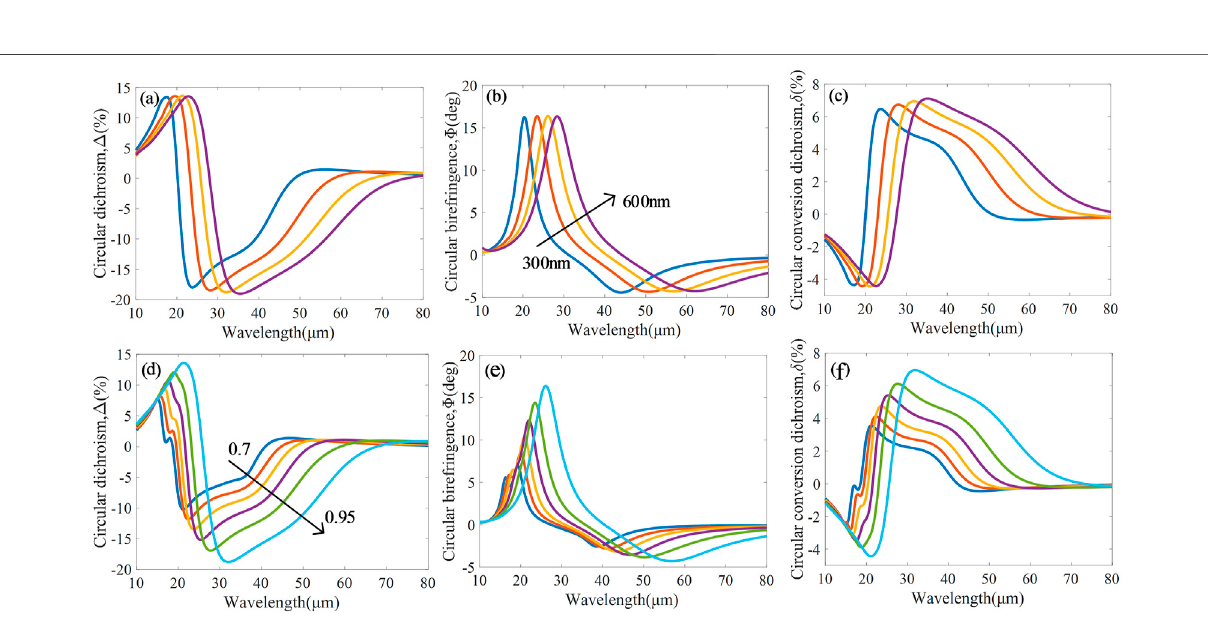
FIGURE 2 | Dependences of (A) circular dichroism, (B) circular birefringence, and (C) circular conversion dichroism on the period of the square BP metamaterial with k =0.95, n =6×10 13 cm − 2 , β =75 ° ,and α =45 ° .Dependencesof (D) circulardichroism, (E) circularbirefringence,and (F) circularconversiondichroismontheduty ratio of the square BP metamaterial with p = 500 nm, n = 6 × 10 13 cm − 2 , β = 75 ° , and α = 45 °